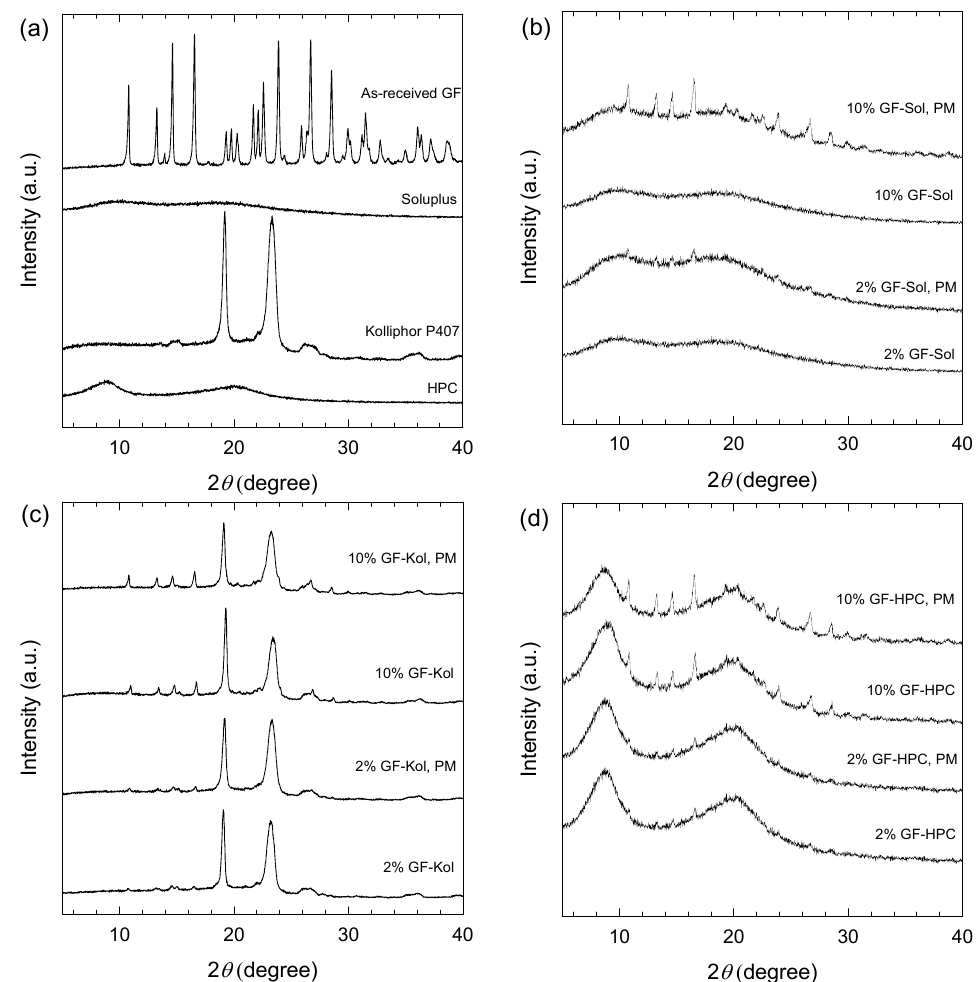
Figure 3. XRD diffractograms of ( a ) as ‐ received GF particles, Soluplus ® (Sol), Kolliphor P407 (Kol), and HPC; ( b ) physical mixtures (PMs) and milled, unsieved extrudate powder of GF ‐ Sol; ( c ) physical mixtures (PMs) and milled, unsieved extrudate powder of GF ‐ Kol; and ( d ) physical mixtures (PMs) and milled, unsieved extrudate powder of GF ‐ HPC.